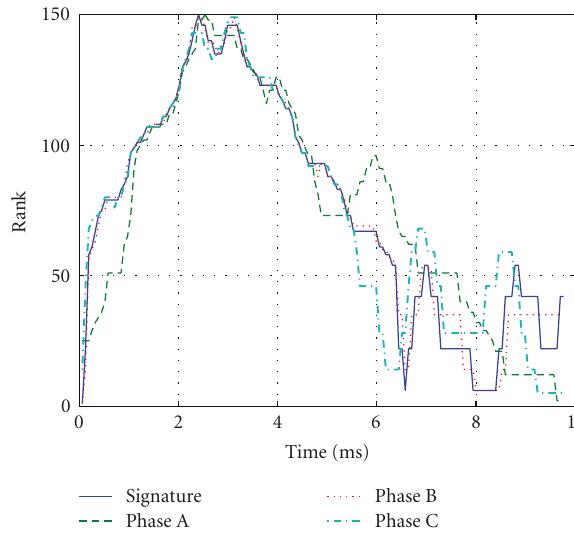
Figure 10: Ranks of signature and transient.